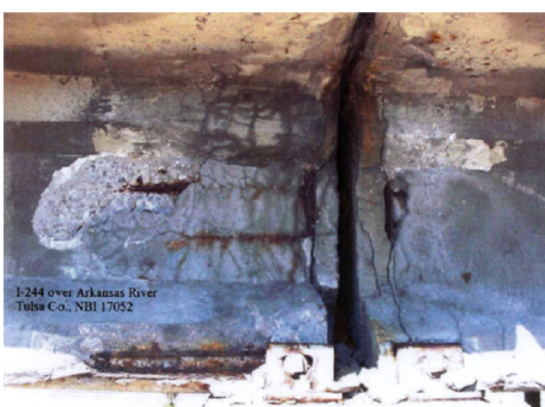
Figure 12. Damage in the end region of an AASHTO bridge girder [21].